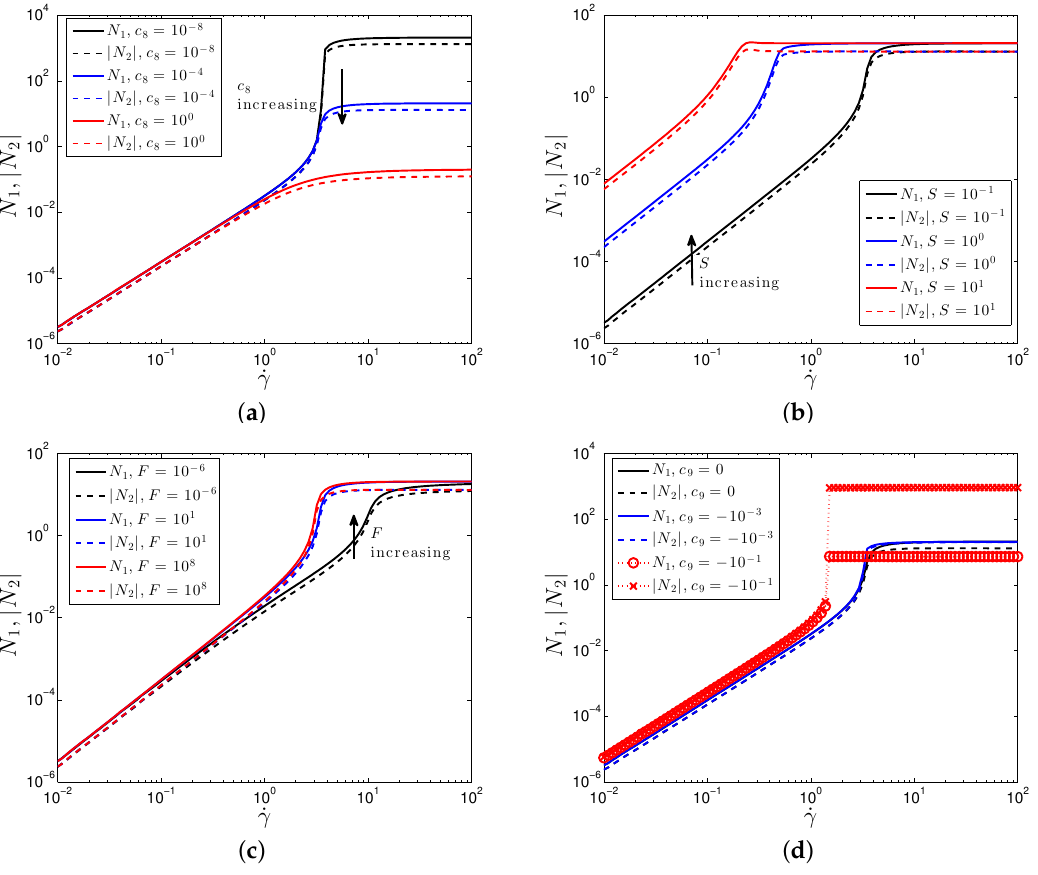
Figure 3. Plot of the first and second normal stress difference, N 1 , N 2 , against shear rate for varying values of ( a ) c 8 , ( b ) S , ( c ) F , and ( d ) c 9 . Parameter values are: S = 10 − 1 , F = 10, c 3 = − 23.5, c 7 = − 0.47, c 8 = 10 − 4 , c 9 =